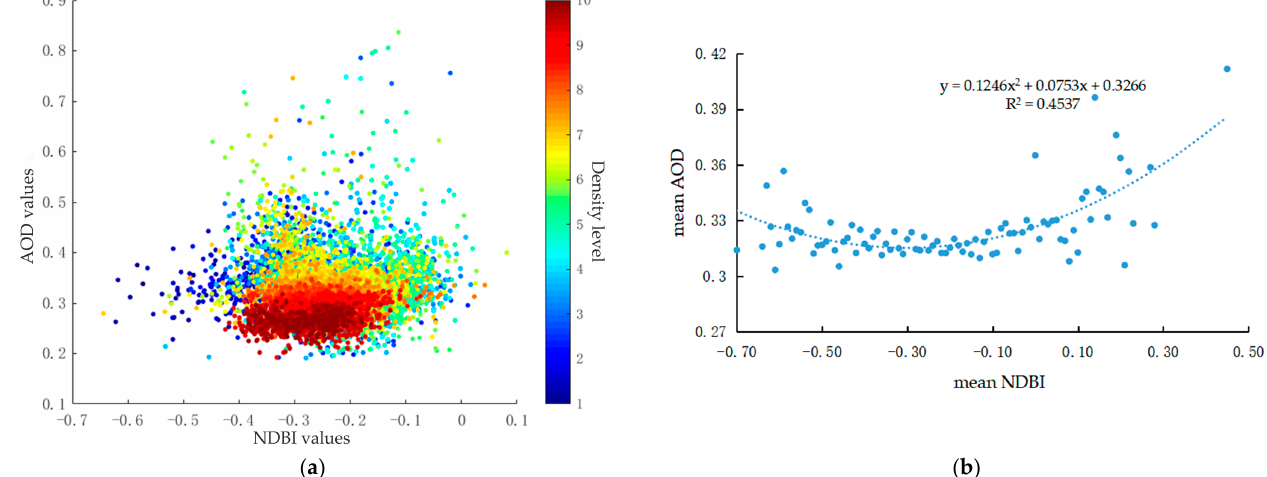
Figure 5. Relationship between AOD (Aerosol Optical Depth) and NDBI (Normalized Difference Build-up Index) values: ( a ) scatterplots and ( b ) regression equation.